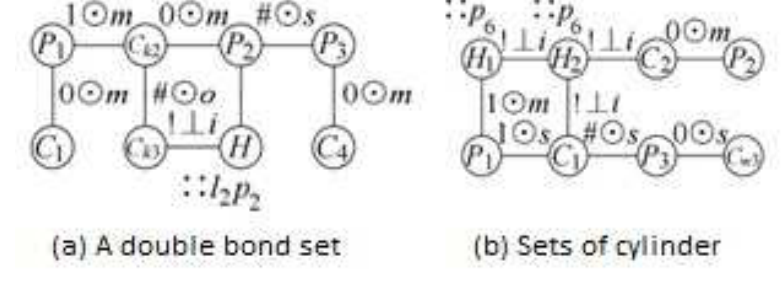
Figure 4. Figure 1’s 3D structure model.